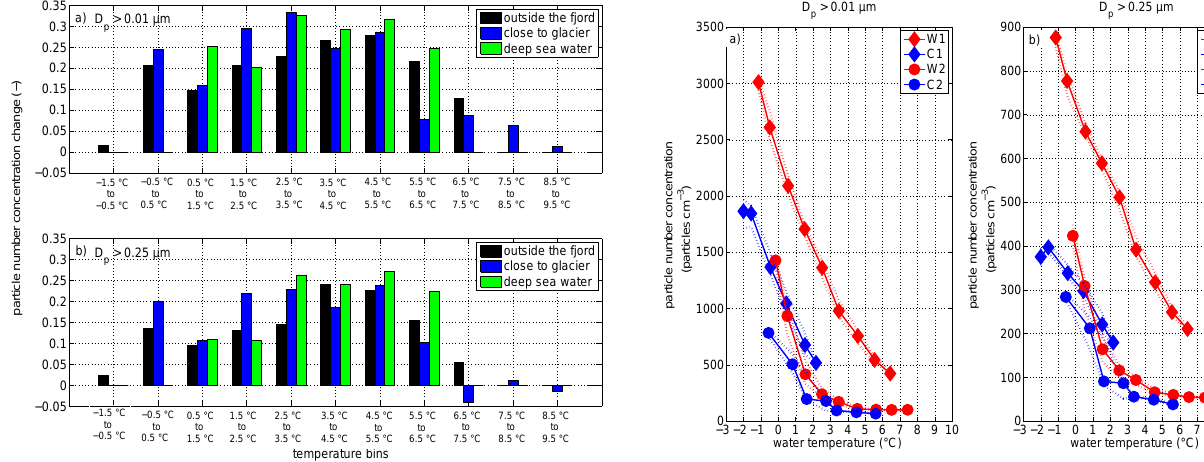
Fig. 6. Medians of the relative change in particle number concentra- tion from one temperature bin to the previous one. Numbers on the x-axis represent the middle of the two temperature bins for which the particle number concentration change was calculated. (a) Mea- surements for particles with D p > 0 . 01µm. (b) Measurements for particles with D p > 0 . 25µm.